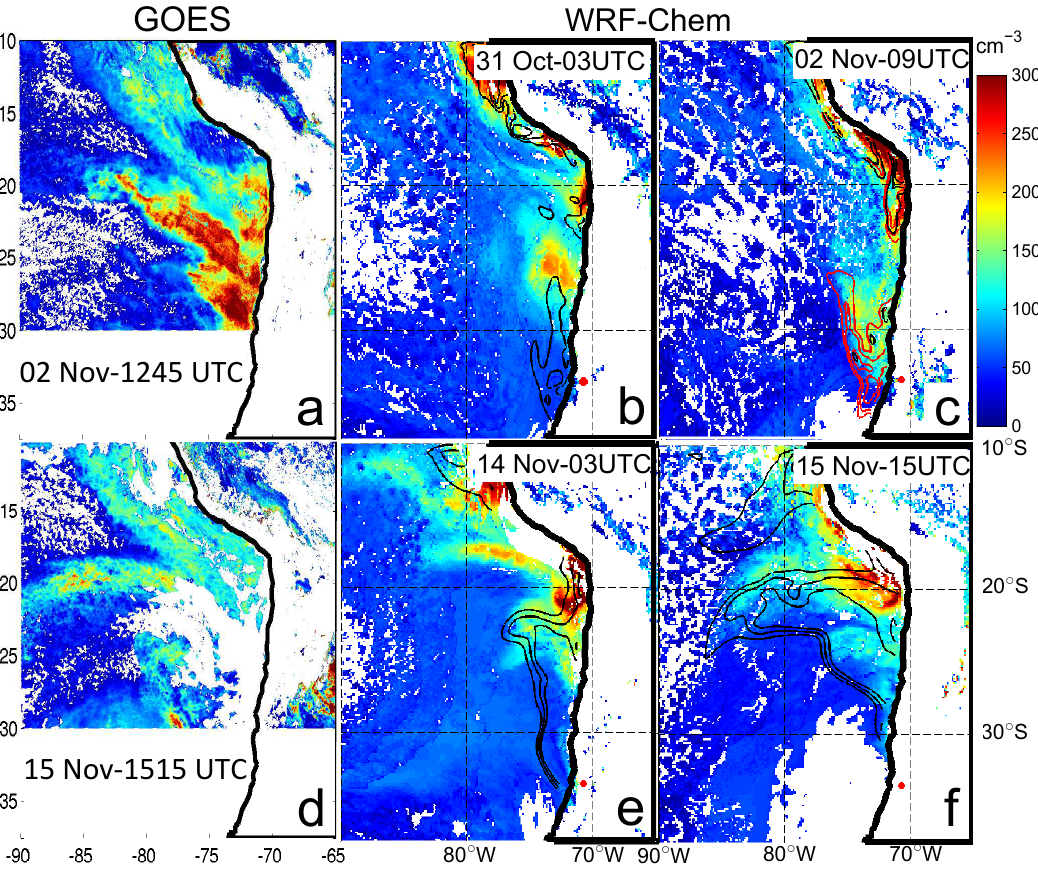
Fig. 16. GOES-derived N d of Hook2 on 2 November at 12:45UTC in (a) and of Hook3 on 15 November at 15:15UTC in (e) , with model N d snapshots on (b) 31 October at 03:00UTC, (c) 2 November at 09:00UTC (chosen because it demonstrates closer agreement with (a) than other times), (e) 14 November at 03:00UTC, and (f) 15 November at 15:00UTC. The red dot marks Santiago. Black contours are FT maximum CCN at 0.5% at 100, 200, and 400cm − 3 . By (c) marine FT CCN is < 100cm − 3 near the region of large N d , so SO 2 at 100, 200, and 400pptv is also shown in red